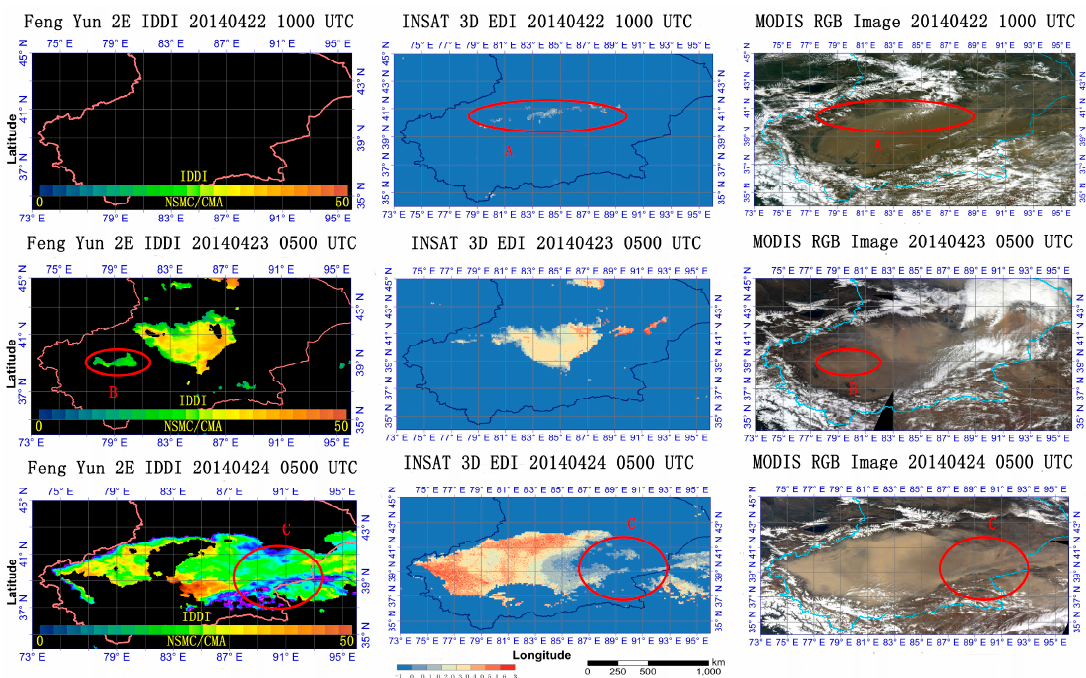
Figure 9. Comparison of Enhanced Dust Index and corresponding MODIS RGB Image and Infrared Difference Dust Index (IDDI) product obtained from FengYun-2E satellite on 22 April 2014.